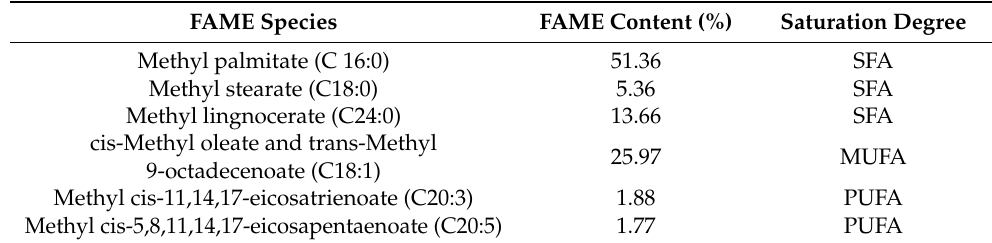
Table 4. Overall FAME profile derived from attached microalgal biomass grown on palm de- canter cake.